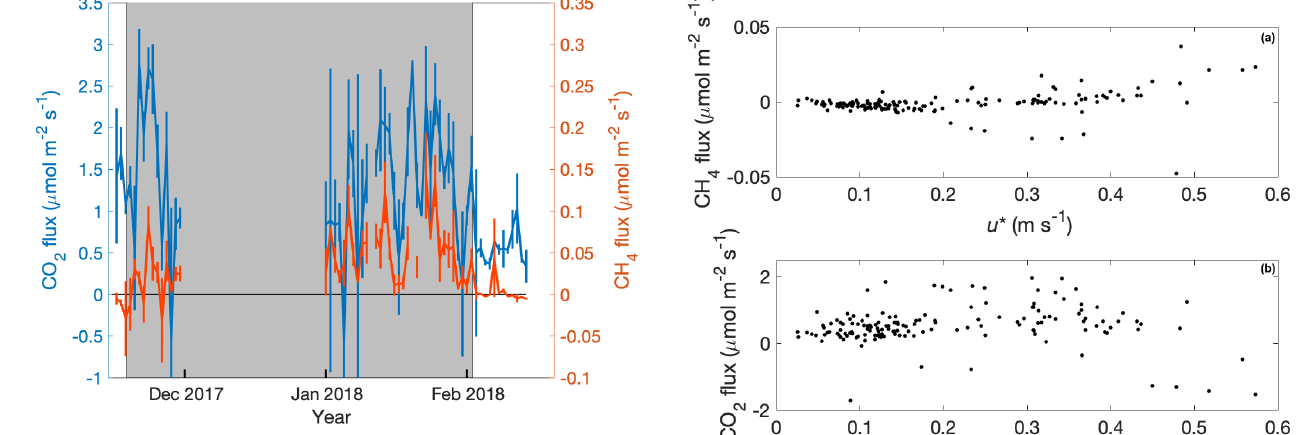
Figure 6. The daily mean and standard error carbon dioxide and methane fluxes with standard error during daytime hours (07:00– 17:00) from the study pasture near Gallatin Gateway, Montana, USA. The gray background denotes the interval during which bi- son were present on the study site.